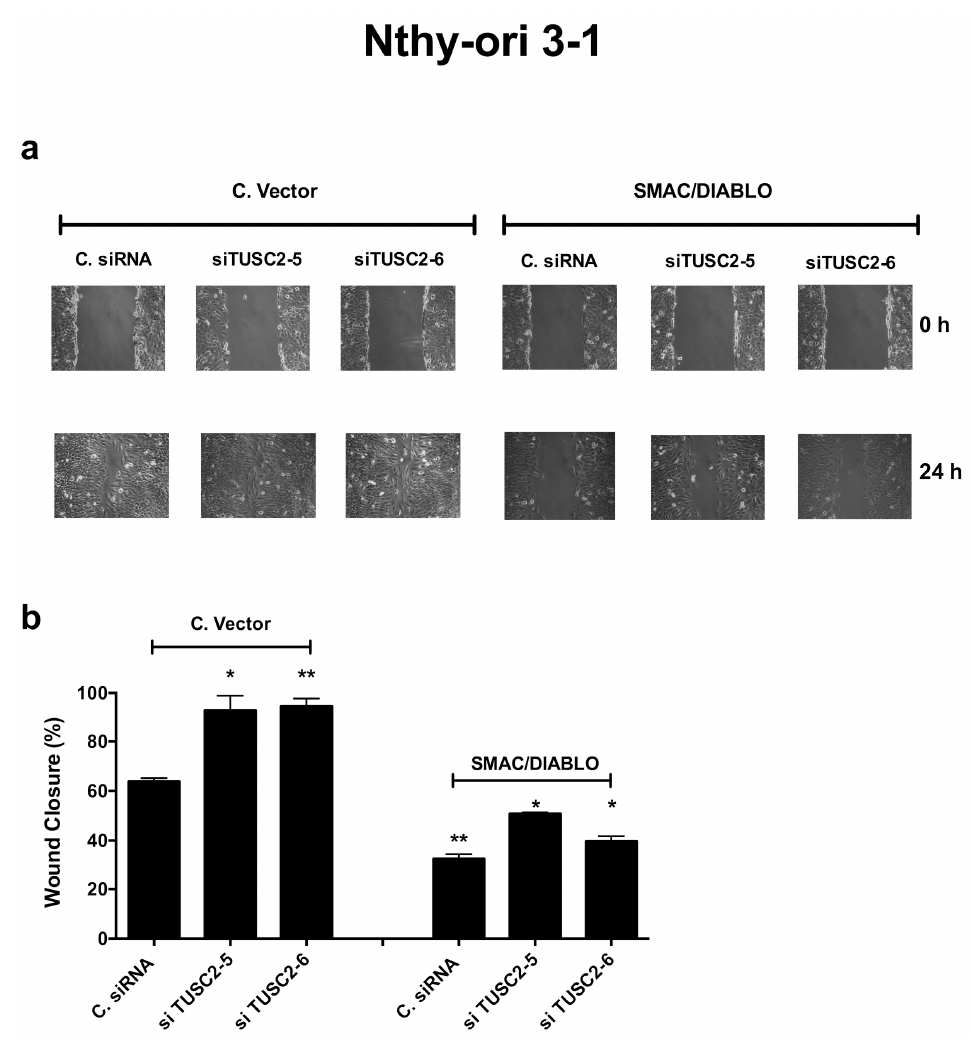
Figure 9. SMAC / DIABLO partially rescued the TUSC2 induced phenotype in the Nthy-ori 3-1 cell line. Figure 9. SMAC/DIABLO partially rescued the TUSC2 induced phenotype in the Nthy-ori 3-1 cell Nthy-ori 3-1 cells were transiently transfected with two di ff erent siRNAs (siTUSC2-5 or siTUSC2-6) or line. Nthy-ori 3-1 cells were transiently transfected with two different siRNAs (siTUSC2-5 or with Control siRNA (named C. siRNA) for 24 h, and then transfected with a SMAC / DIABLO plasmid siTUSC2-6) or with Control siRNA (named C. siRNA) for 24 h, and then transfected with a or Control Vector. Then a wound was generated on the confluent monolayer of transfected cells. SMAC/DIABLO plasmid or Control Vector. Then a wound was generated on the confluent Cells were imaged under a microscope at 10x magnification ( a ) and the wound closure distance was monolayer of transfected cells. Cells were imaged under a microscope at 10x magnification ( a ) and quantified and expressed as the percentage of wound closure ( b ). Values represent the average of the wound closure distance was quantified and expressed as the percentage of wound closure ( b ). duplicate experiments ± standard errors. * p < 0.05 and ** p < Values represent the average of duplicate experiments ± standard errors. * p < 0.05 and ** p < 0.01.